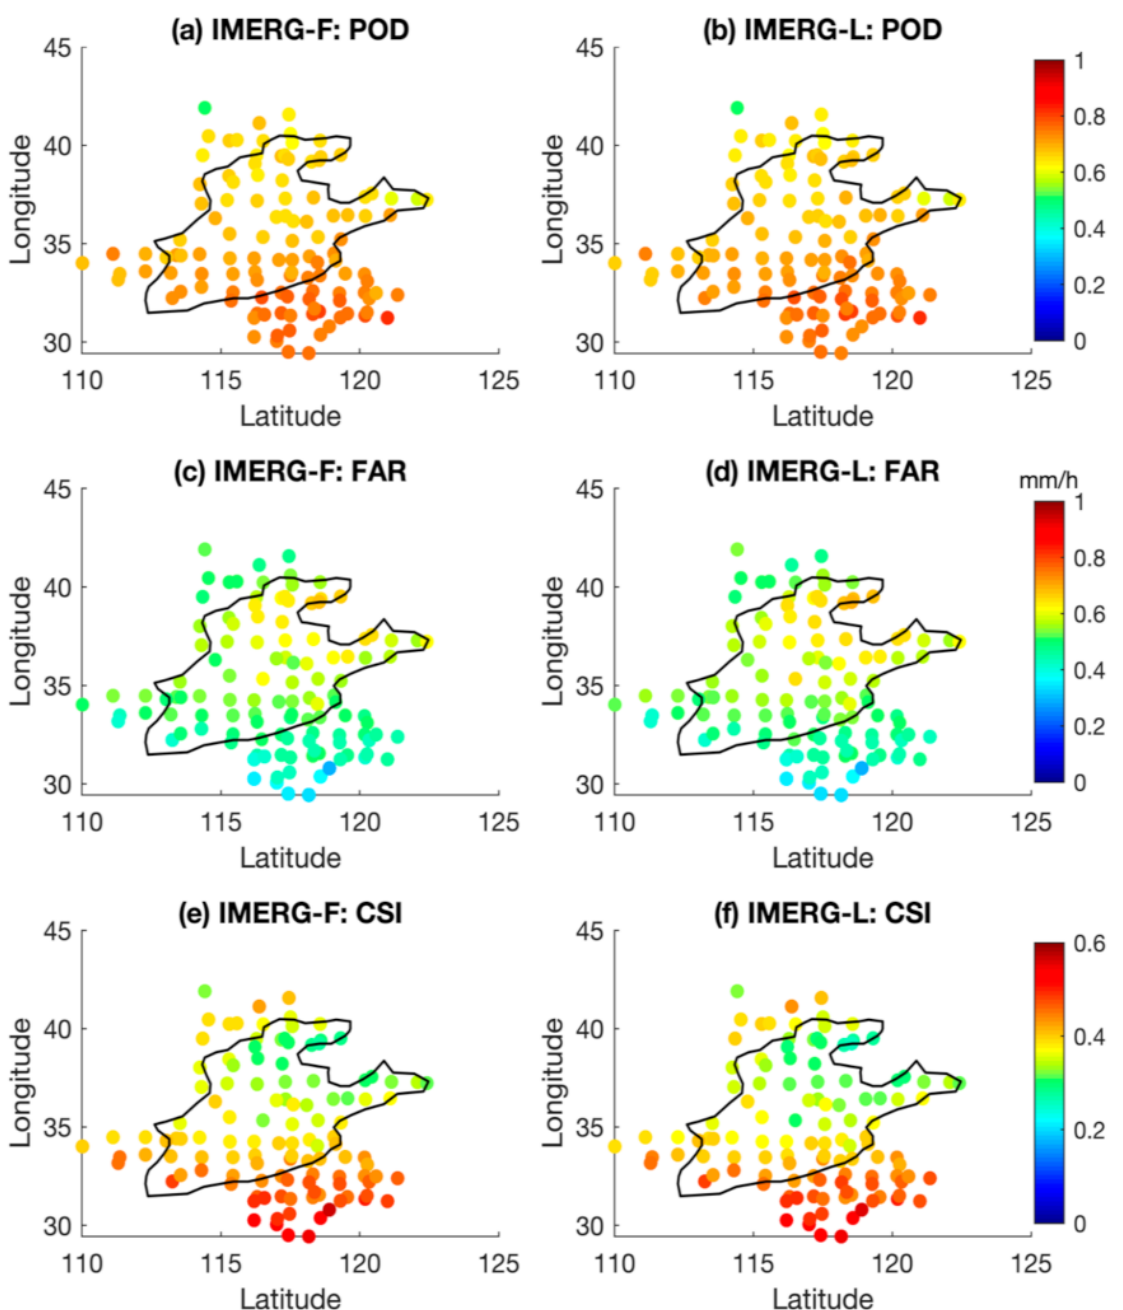
Figure 6. The distributions of three metrics POD, FAR, and CSI for the IMERG-F and IMERG-L precipitation products at the daily